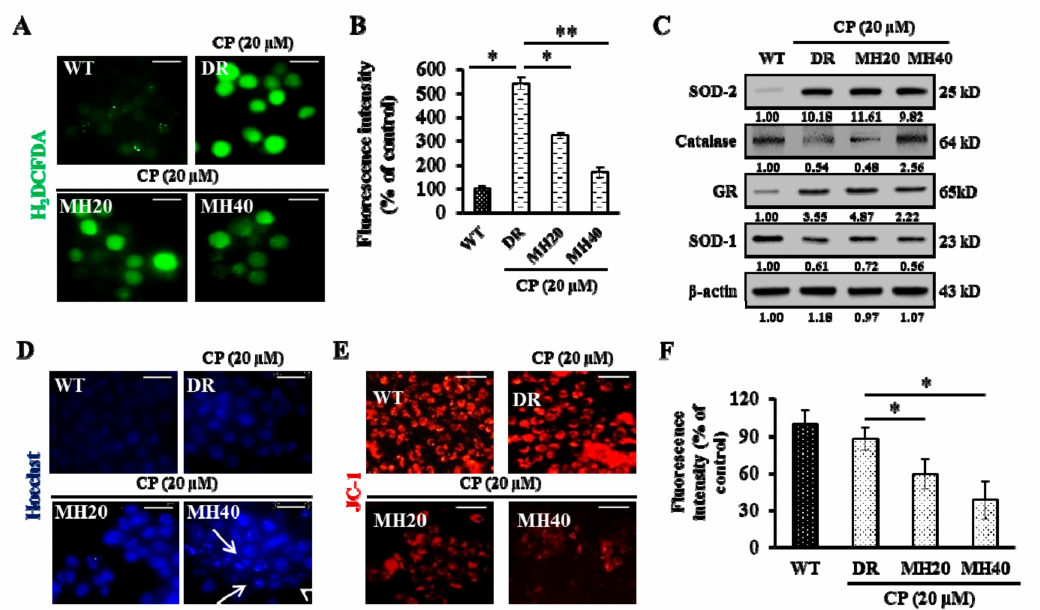
Figure 5. E ff ect of MH on CP-induced oxidative stress in HepG2 DR cells ( A ) Intracellular reactive oxygen species (ROS) production in HepG2 WT and HepG2 DR cells after drug treatments was observed under a fluorescence microscope (magnification: 400 × ; scale bar: 0.1 mm). ( B ) Fluorescence intensity was measured using the ImageJ software. ( C ) Western blot analysis of antioxidant markers was performed using specific antibodies against SOD-2, catalase, GR, and SOD-1; β -actin was used as a loading experiments were performed. ( D ) HepG2 WT and HepG2 DR cells were stained with Hoechst 33342 after drug treatments and assayed under a fluorescence microscope (magnification: 400 × ; scale: 0.1 mm). White arrows indicate bright blue pyknotic nuclei. ( E ) Mitochondrial membrane potential disruption in HepG2 WT and HepG2 DR cells was assayed using the red JC-1 stain after drug treatments and visualized by fluorescence microscopy (magnification: 200 × ; scale bar: 0.1 mm). ( F ) Fluorescence intensity of